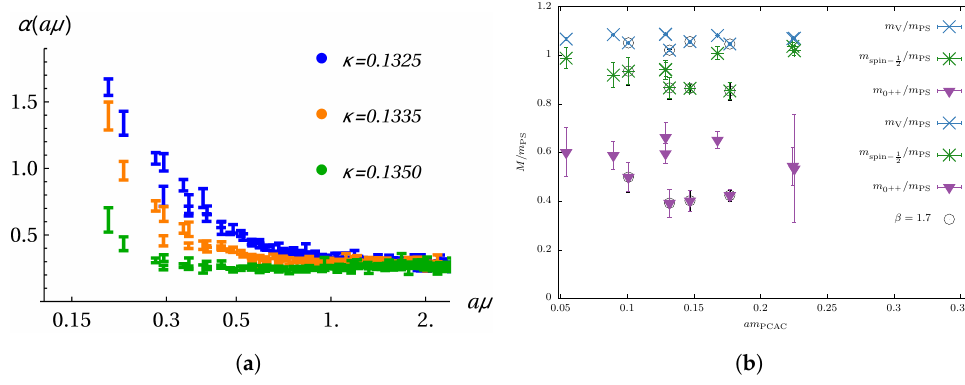
Figure 3. Numerical results for properties of adjoint QCD with two Dirac flavors. ( a ) Running of the coupling for increasing κ corresponding to a decreasing fermion mass, determined from gluon and ghost propagators; see [72] for further details. ( b ) Masses of bound state particles in units of the pseudoscalar meson mass (pNGb-like pion in QCD) as a function of the partially conserved axial current mass (proportional to renormalized fermion mass). Two different values of the gauge coupling are combined. m V is the vector meson mass, 0 ++ indicates the scalar glueball mass, m corresponds to the gluino–glue mass in SYM. The data are obtained at a inverse gauge coupling of β = 1.5 with some additional points at β = 1.7; see [66] for further